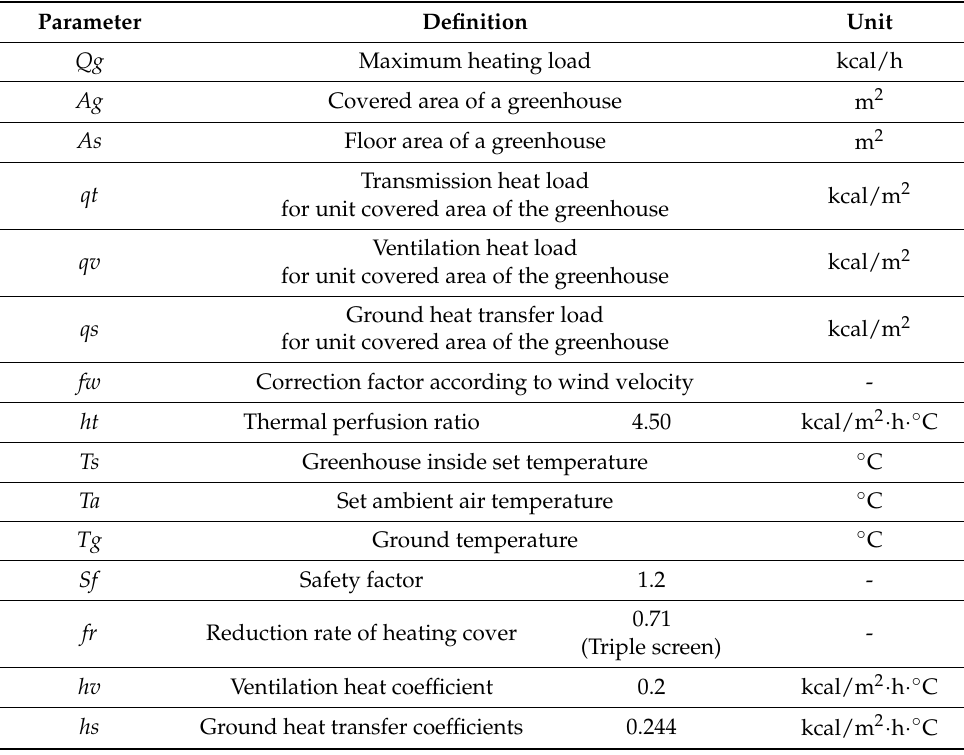
Table 1. Factors required for the calculation of the heating